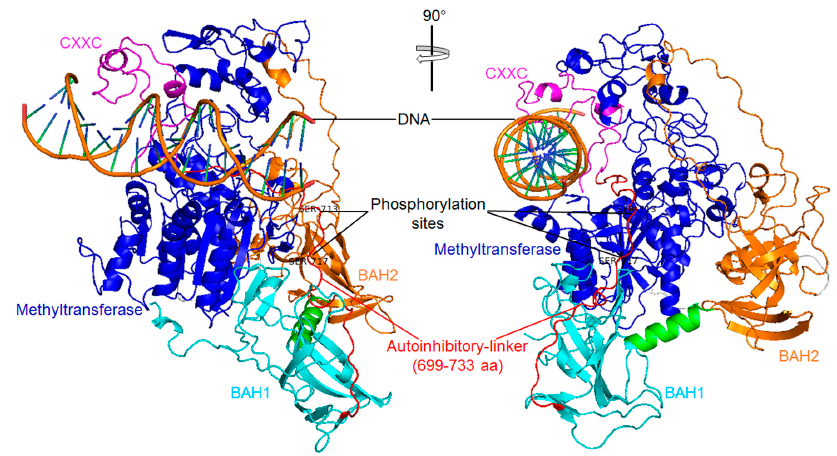
Figure 10. Structural characterization of mouse DNA methyltransferase (cytosine-5) 1 (650–1602) in complex with DNA (PDB ID: 3PT6). Ribbon representation of the complex in two orthogonal views. The zinc finger-like motif (CXXC), bromo-associated homology domain 1 (BAH1) and 2 (BAH2), and methyltransferase domain are coloured in magenta , cyan , orange and blue , respectively. The autoinhibitory linker (CXXC-BAH1 linker) is coloured in red . Two phosphorylation sites (SER-713 and SER-717) are also shown in the figure.